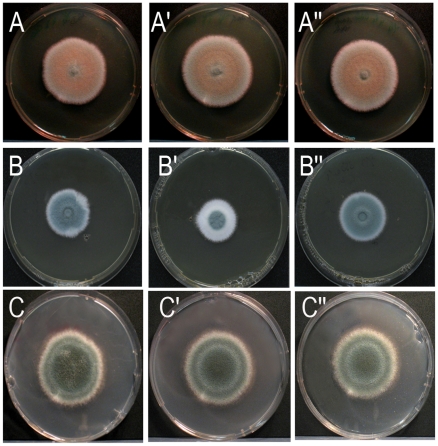
Impaired sporulation of the Δafocht1 mutant in the presence of high calcium concentrations.Colonies of the parental strain AfS35 (A, B, C), the Δafocht1 mutant (A′, B′, C′) and the complemented strain (A″, B″, C″) were grown at 37°C on YG medium (A to A″), YG medium supplemented with 350 mM CaCl2 (B to B″) and AMM medium supplemented with 500 mM CaCl2 (C to C″).